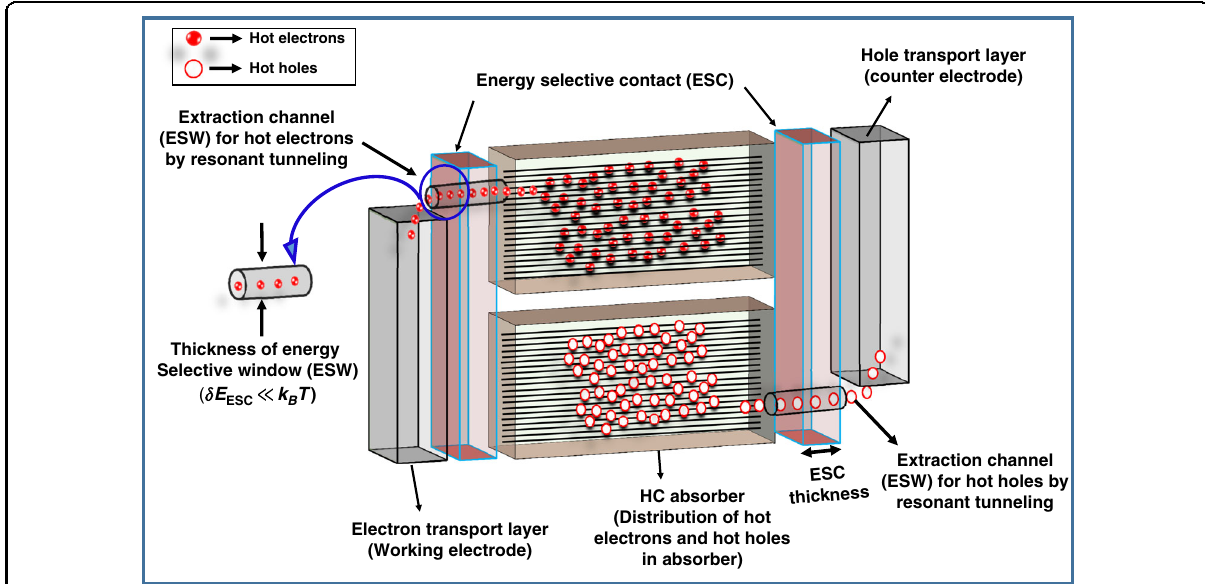
Fig. 12 The schematics showing HC solar cell. Energy selective window (ESW) with thickness δ E << K B T serve as channel for selective and ef fi cient